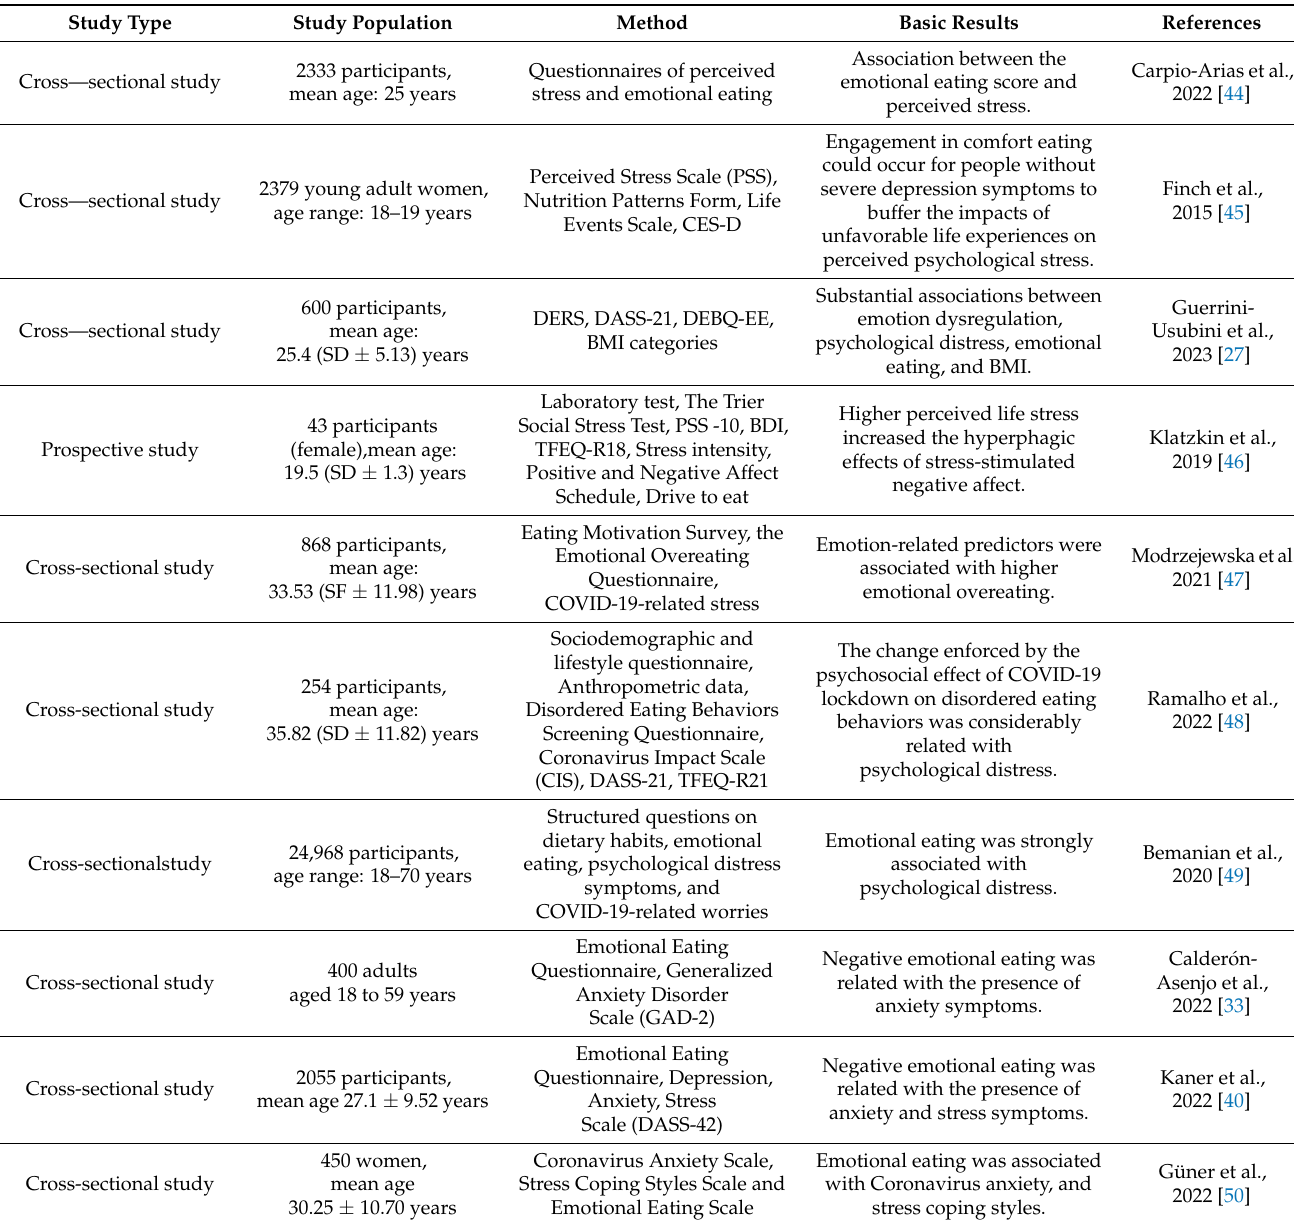
Table 3. Clinical studies evaluating the association of emotional eating with